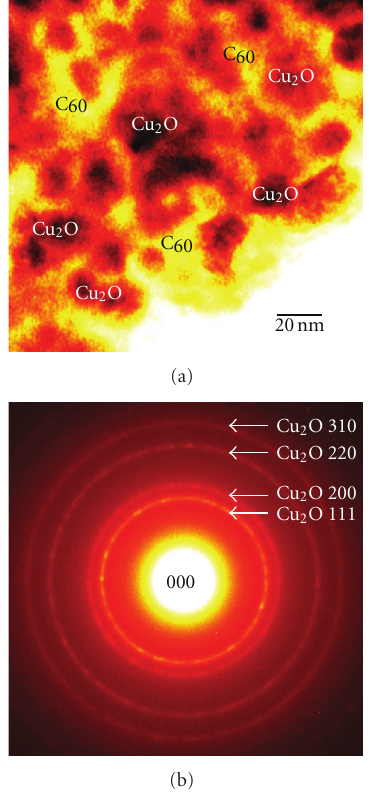
Figure 12: (a) TEM image and (b) electron di ff raction pattern of Cu 2 O:C 60 structure.